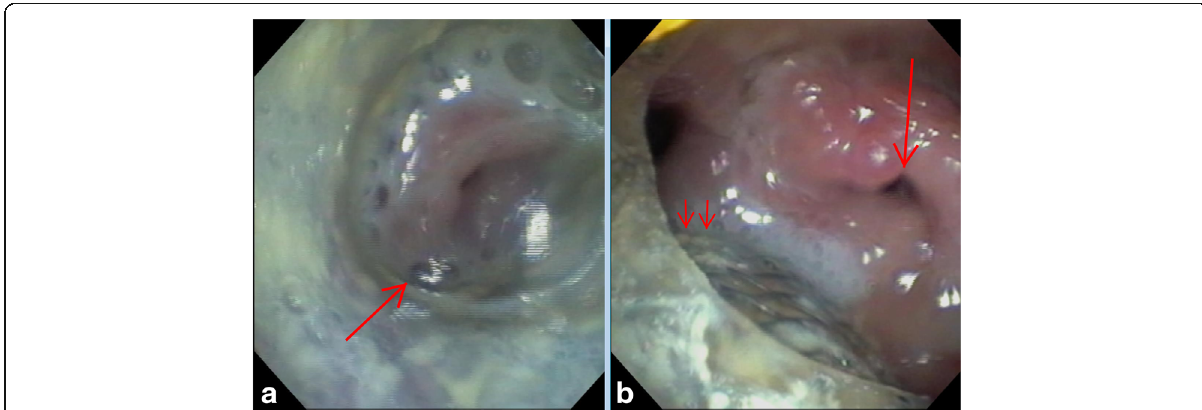
Fig. 1 Supplemental Digital Content 1. a . Distal migration of previously placed metallic tracheal stent into right mainstem bronchus. b Consequent high-grade right mainstem bronchostenosis (single arrow); proximal revision of metallic tracheal stent reveals large tracheo-esophageal defect and esophageal stent